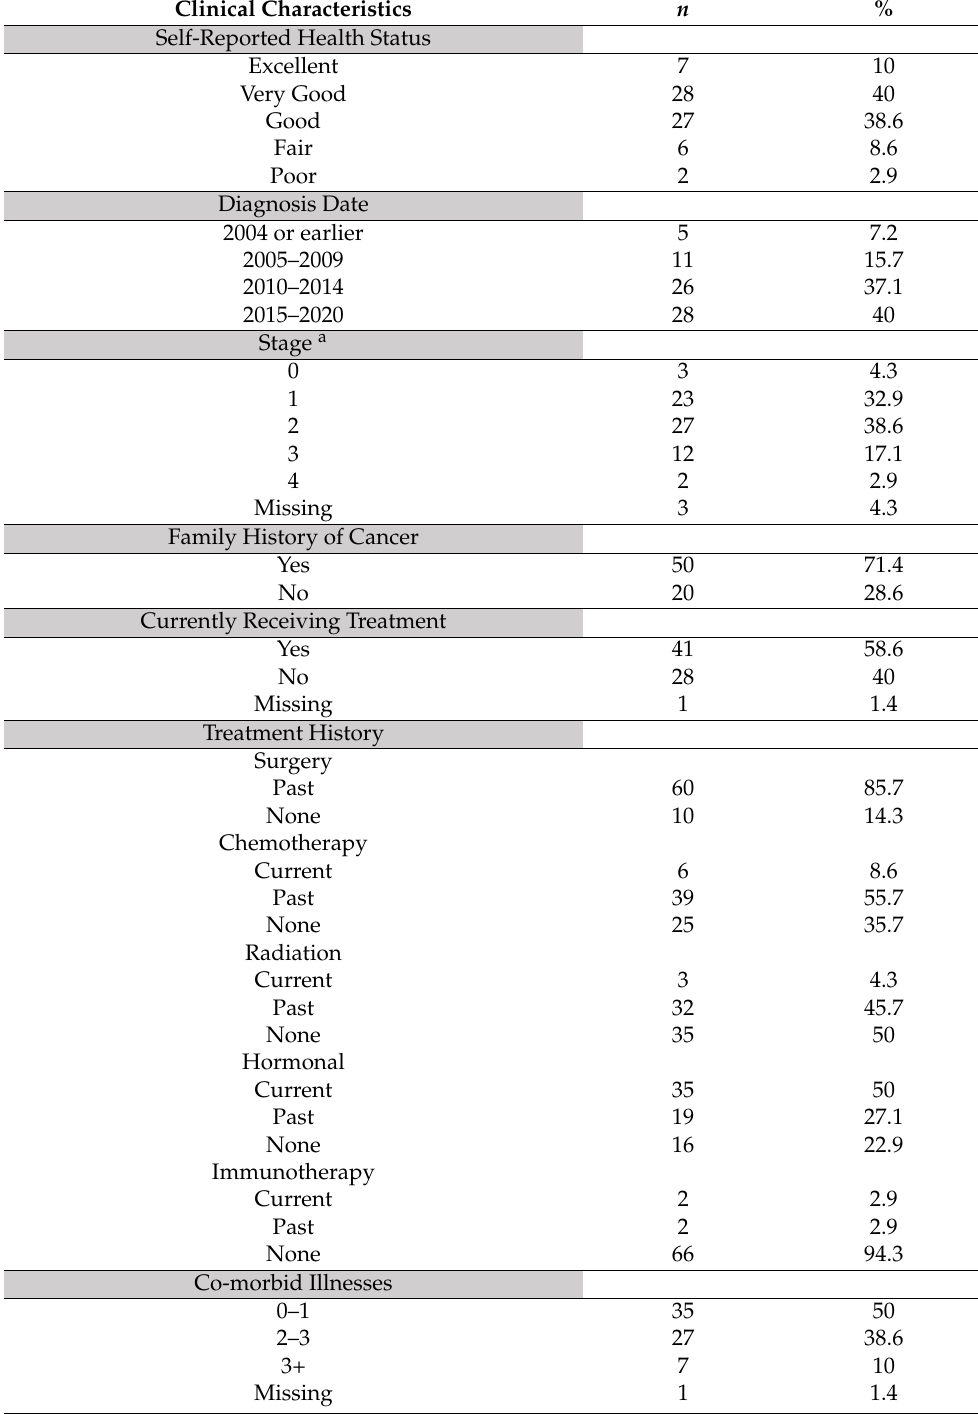
Table 2. Clinical characteristics of study